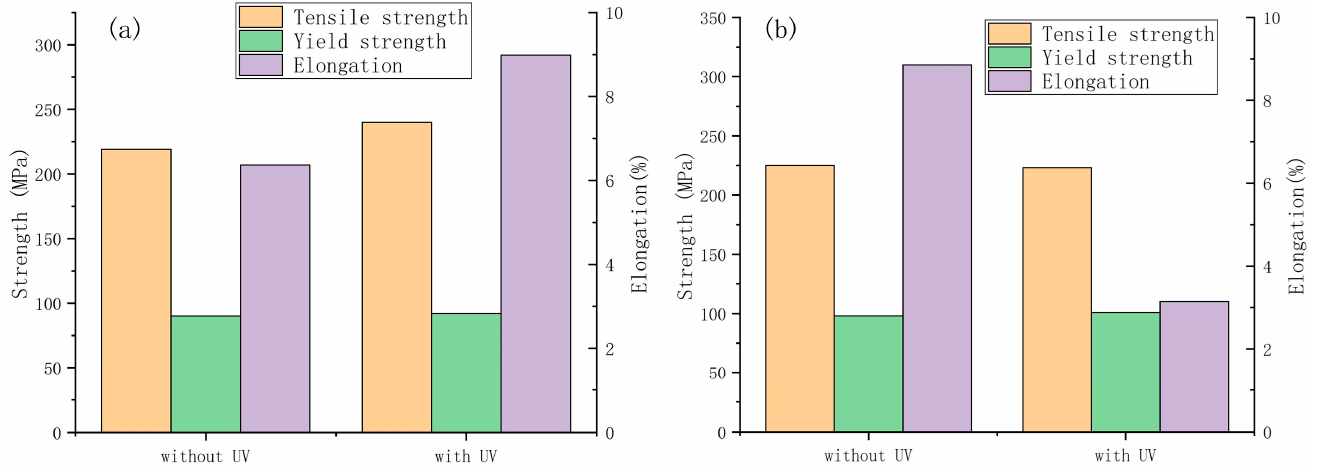
Figure 12. Tensile test results of single-channel multilayer deposition samples: ( a ) horizontal direc- tion; ( b ) vertical direction. ( b ) vertical